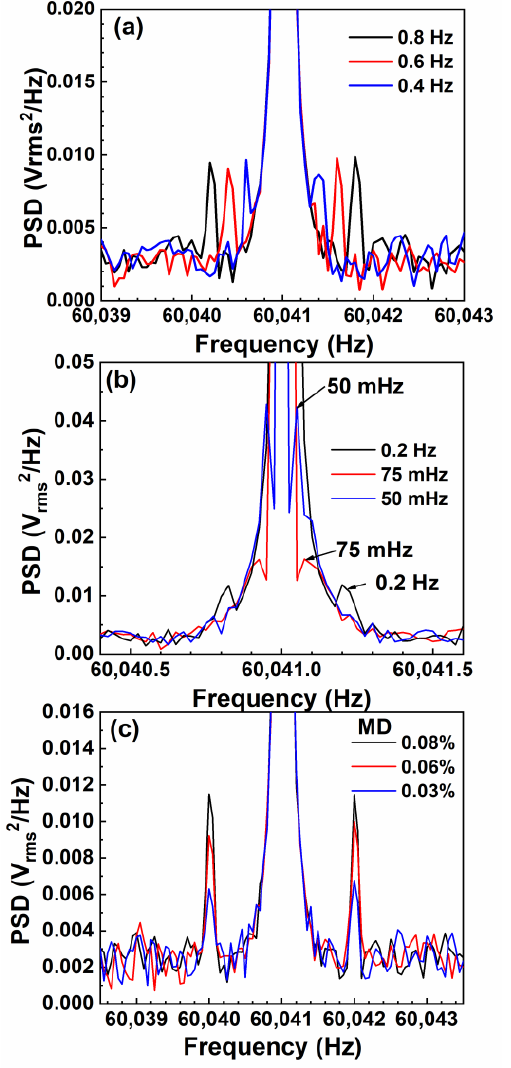
Figure 6. Modulation peaks at MD = 0.05% at various modulation frequencies ( a , b ) and at different MDs at a modulation frequency of 1 Hz ( c ).